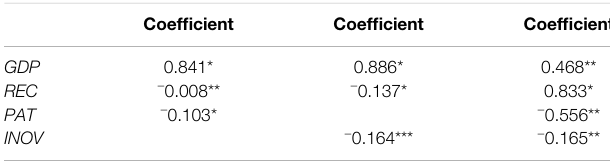
TABLE 4 | Long-run analysis using pooled OLS with fi xed effects. TABLE 5 | Quantile regressions analysis with fi xed